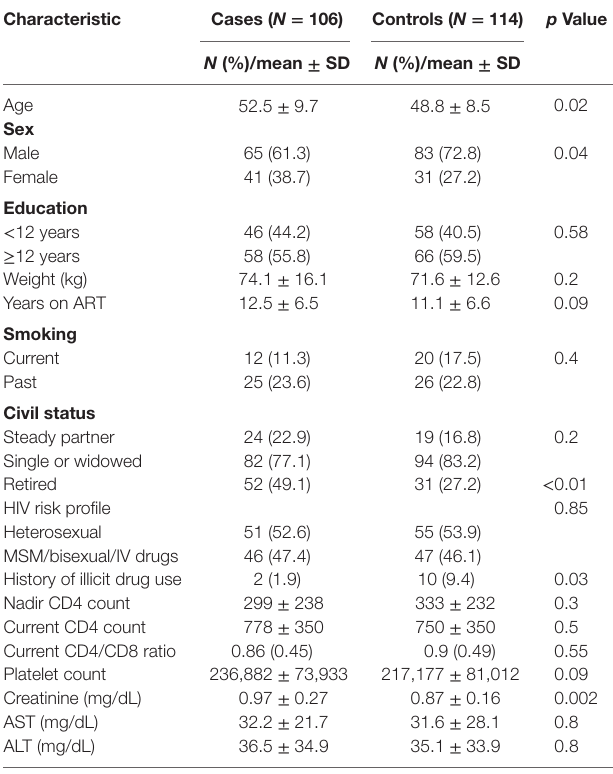
TaBle 1 | Demographic and laboratorial characteristics of cases and controls.